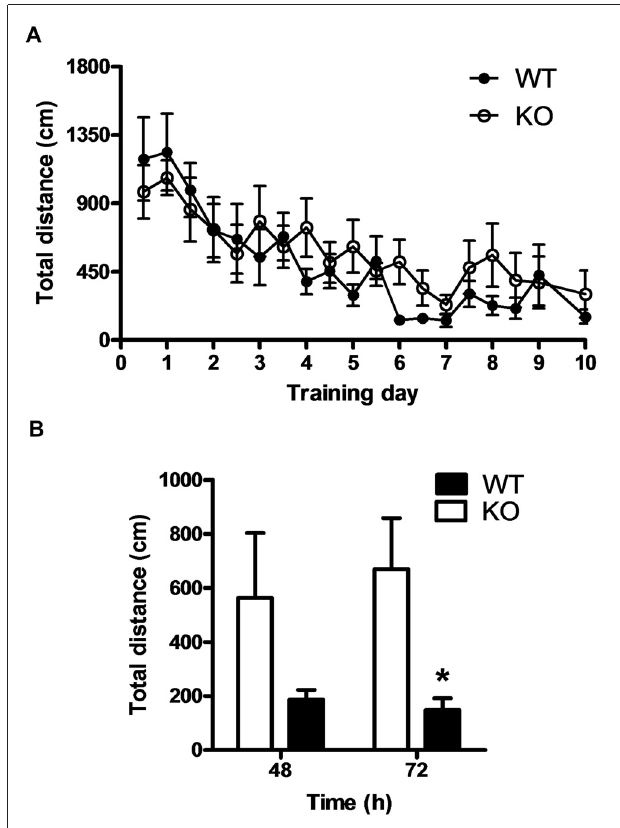
FIGURE 8 | PROT − / − mice exhibit normal memory acquisition but impaired memory extinction. (A) Compared to WT, PROT deficient mice (KO) showed normal spatial reference memory acquisition in the Morris water maze during the training period and the probe trial at day 10. (B) KO mice displayed impaired memory extinction; after the hidden platform was moved to the opposite quadrant of the maze, KO animals persevered searching for the platform in the former target quadrant and did not show decrease in their path length as compared with WT. Data are shown as means ± SEM; n = 6 for each genotype; (B) two-tailed Student’s t test; ∗ p <